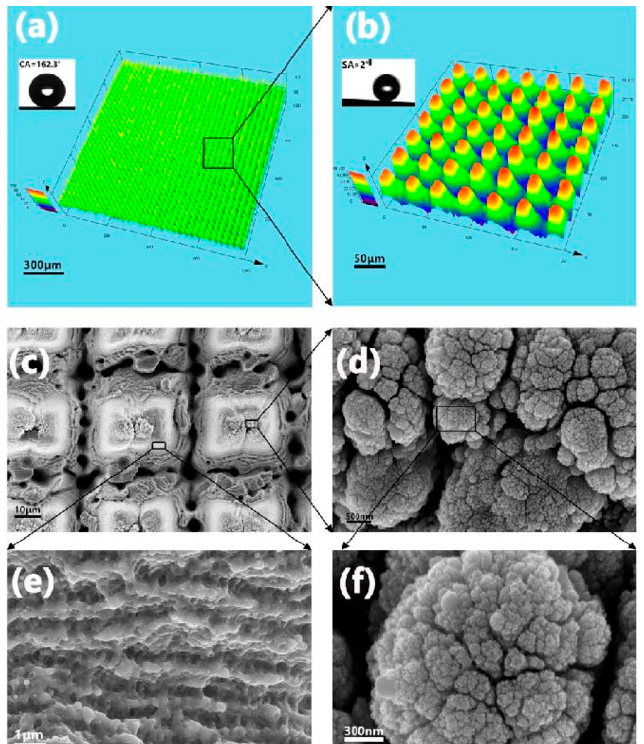
Figure 10. The LST processed Ti samples: ( a ) surface 3D profile, ( b ) magnified 3D profile, ( c – f ) SEM micrographs showing the LIPSS and MNHS topographies with the magnification of rectangular regions [112] (reproduced with permission number: 42, 3936-3939 (2017), Optical Society).